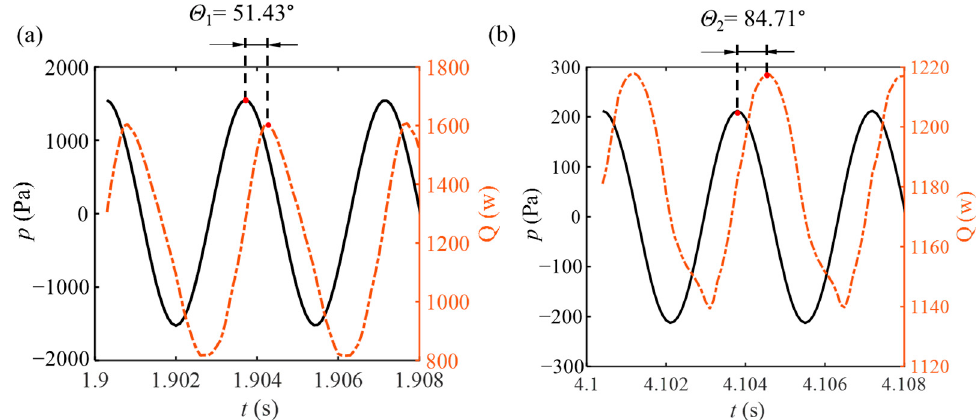
Figure 18. Global Rayleigh Index analysis: phase difference between the pressure and heat release fluctuations ( a ) T H = 500 K and ( b ) T H = 1800 K, where S N = 0.45, V a = 180 L/min and T i = 300 K.